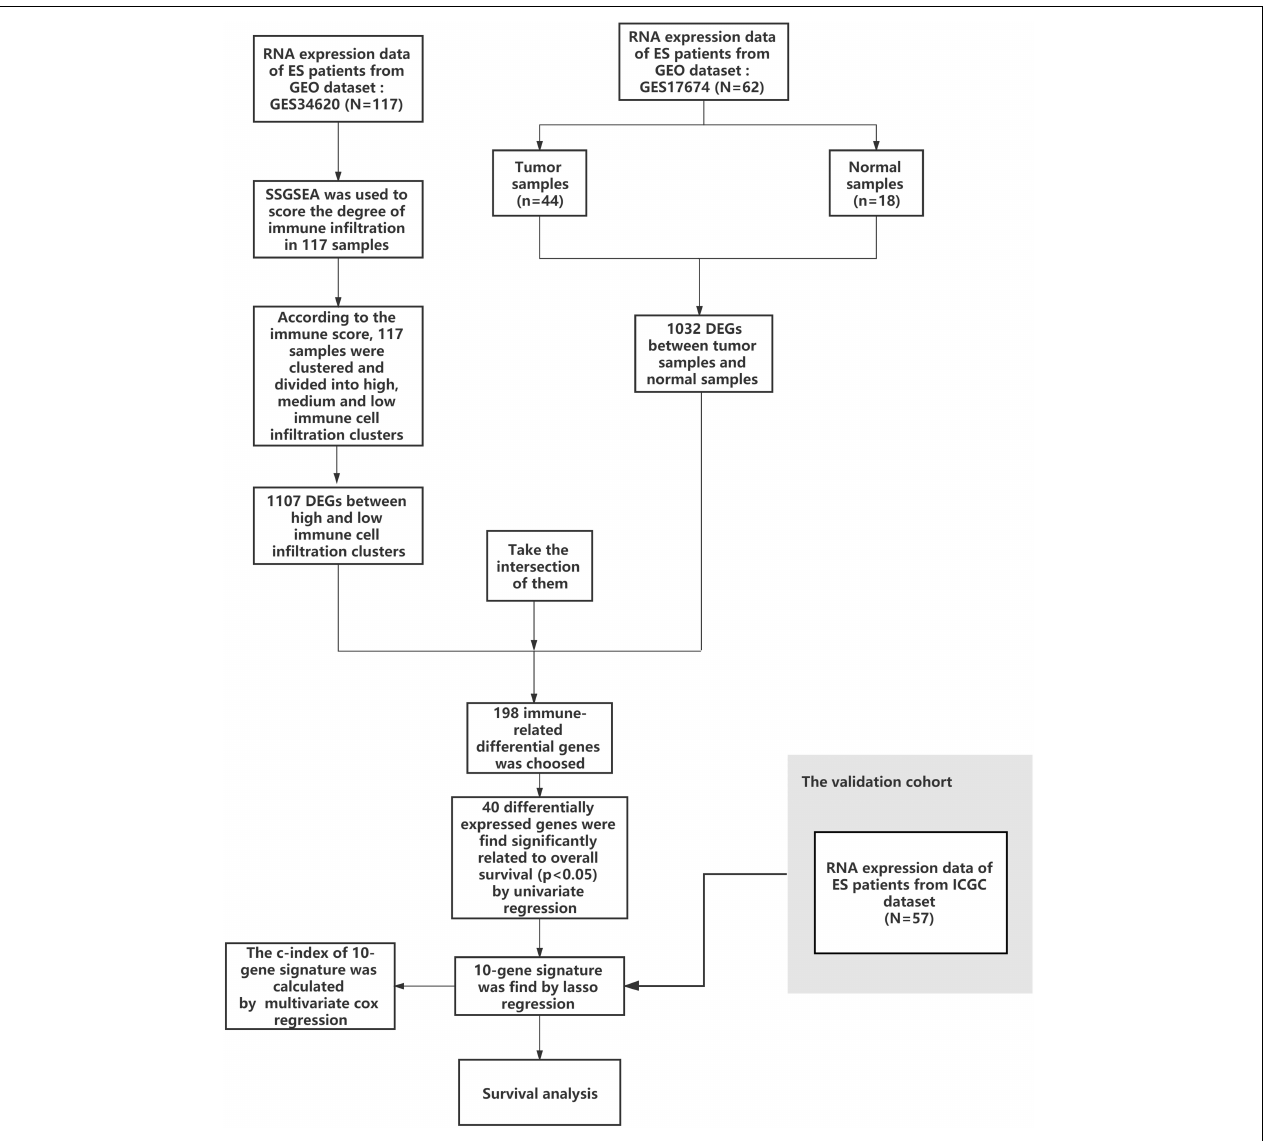
FIGURE 1 | Flow chart of data collection and